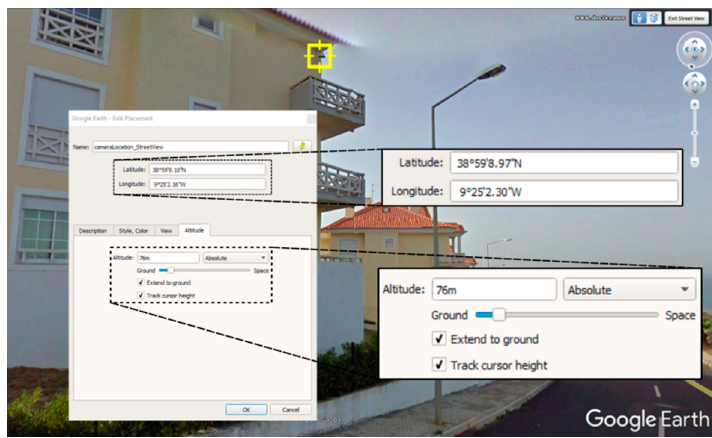
Figure 6. Camera position retrieved from Google Street View. Yellow cursor indicates the camera.